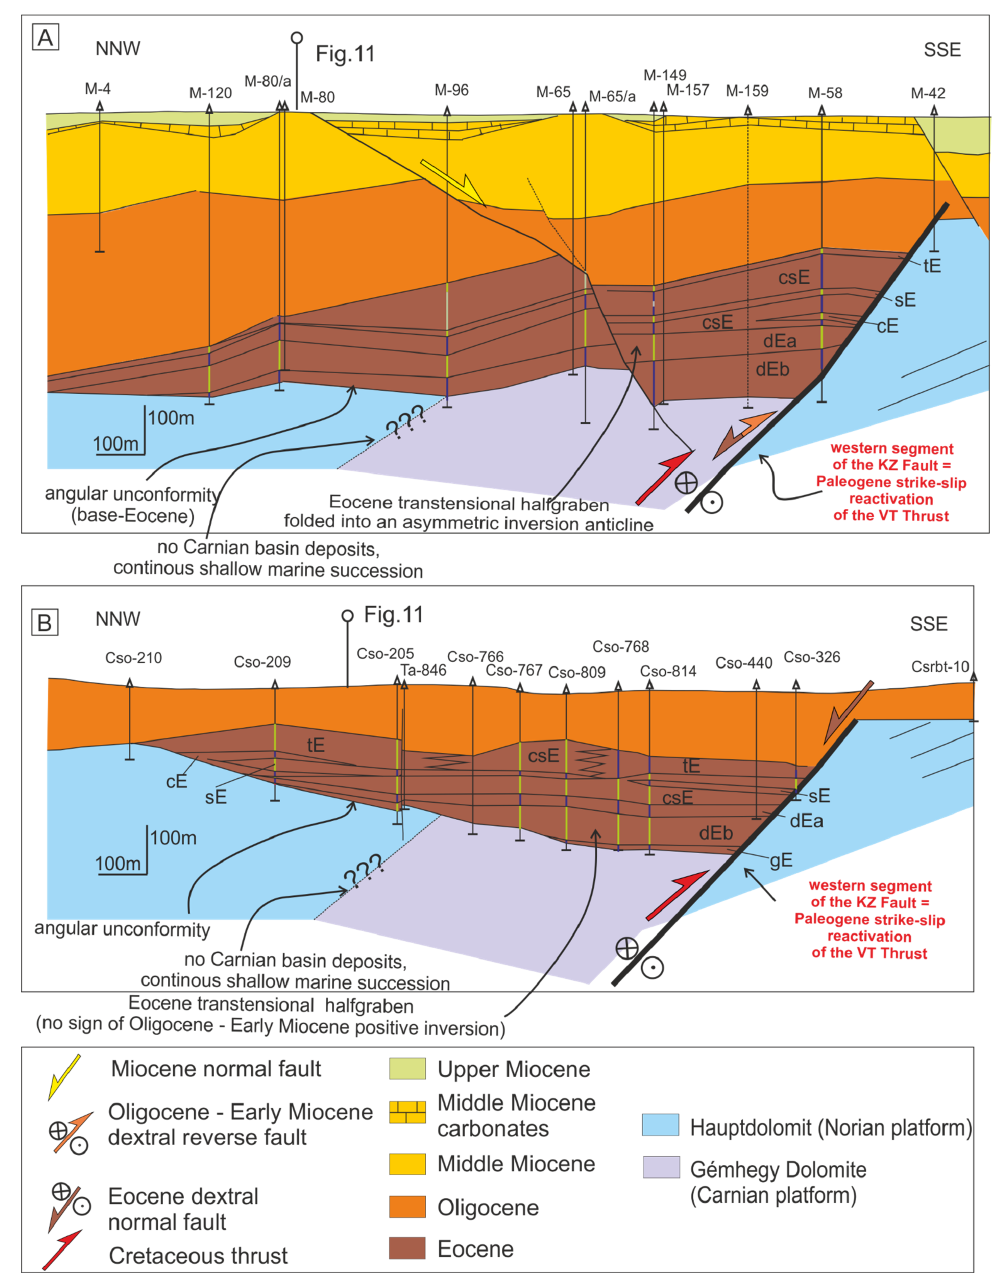
Figure 10. Sections across the western segment of the KZ Fault. ( A ) Section across the eastern part of the western segment of the KZ Fault. ( B ) Section across the western part of the western segment of the KZ Fault. For the location of the section, see Figure 4. The abbreviations “Fig.” refer to figures of this